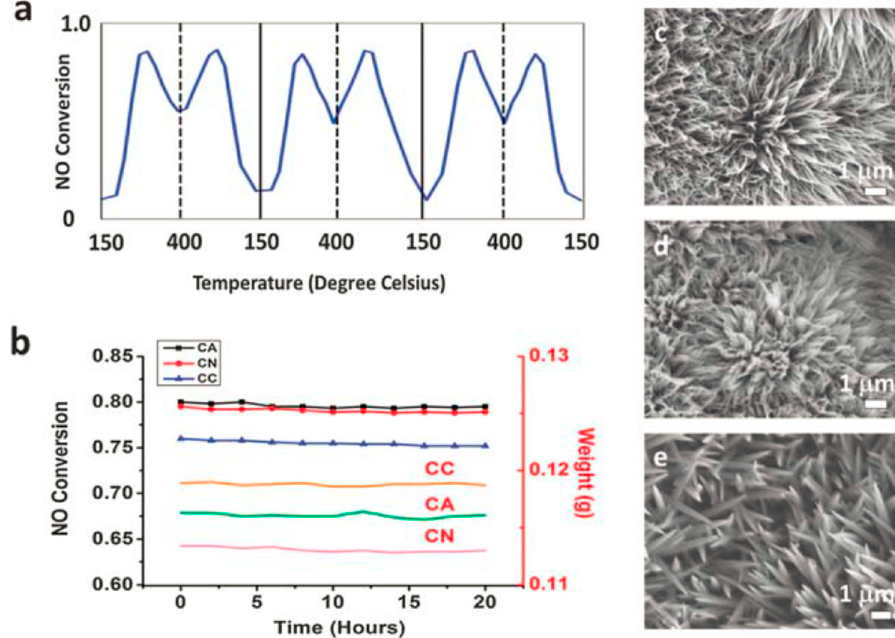
Figure 15. ( a ) Catalytic NO oxidation performance with repeated heating and cooling; ( b ) NO oxidation efficiency and weight measurement during long term steady investigation at 275 °C for CA and CN and 325 °C for CC; ( c – e ) SEM images of CN, CA and CC respectively after all stability tests. Reprinted with permission from [16], Copyright RSC, 2013.